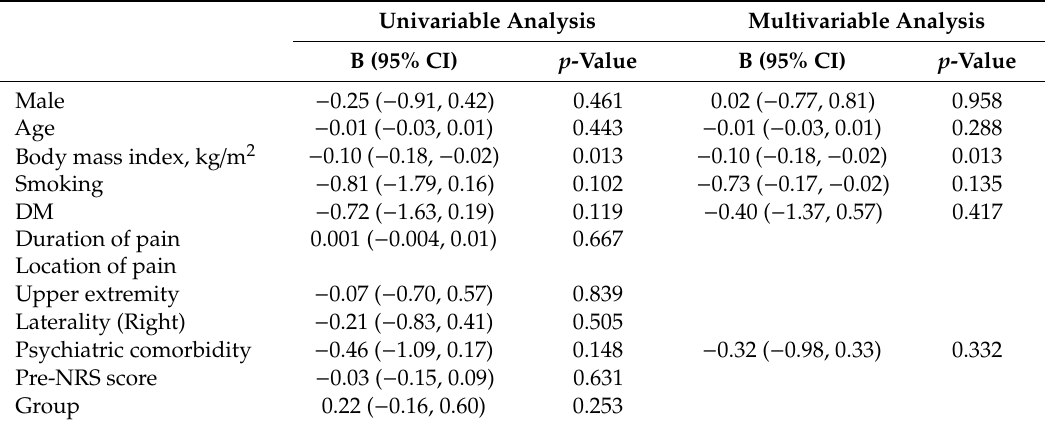
Table 3. Multivariable analysis between temperature increase and clinical variables (r2 = 0.052) .